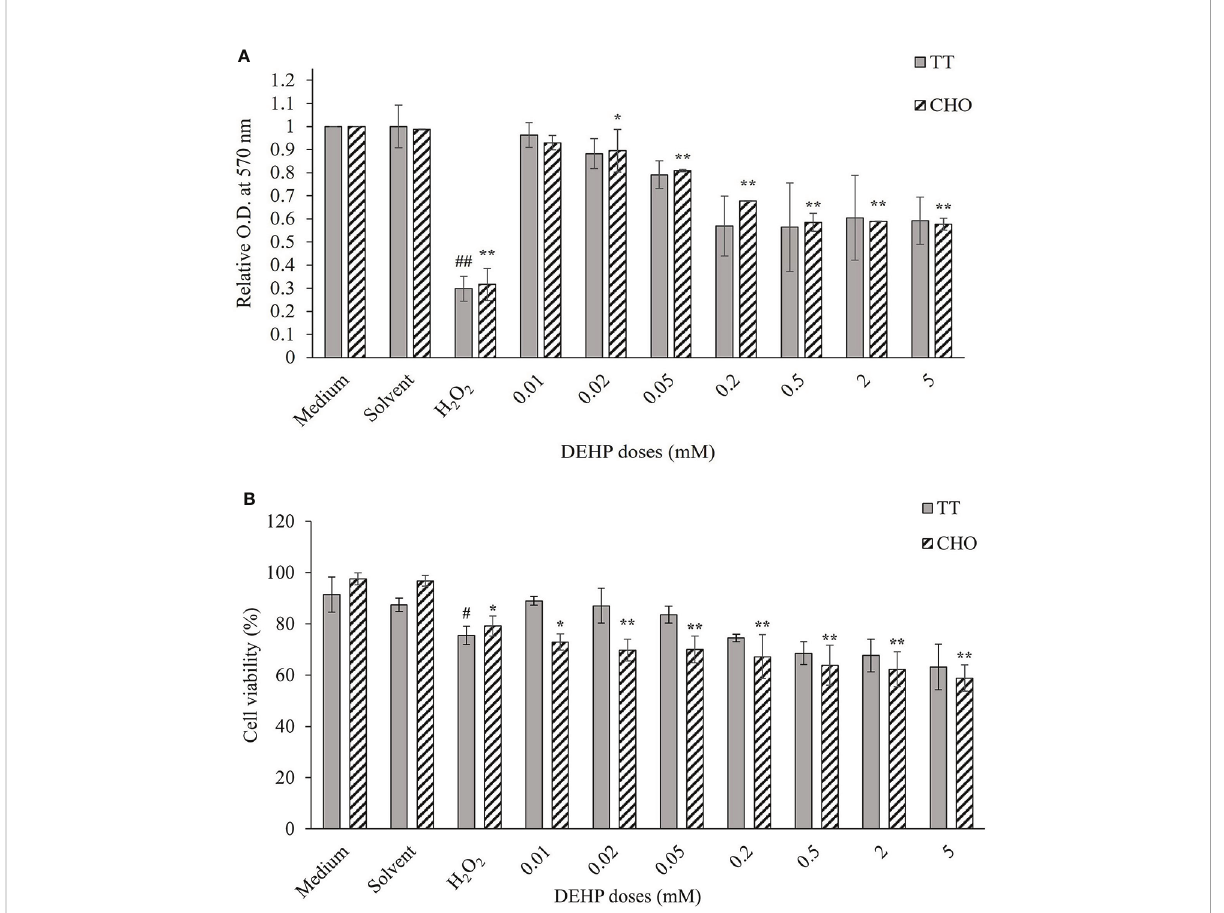
FIGURE 1 Cellular viability in DEHP-exposed TT and CHO cell lines. (A) MTT assay results are displayed as a mean of the optical density (OD) at 570 nm, at each treatment level normalized to the relative solvent (DMSO) in each cell line. Data are expressed as mean ± SD of two independent experiments. (B) Trypan Blue exclusion assay results are expressed as the percentage of viable cells out of the total cells at each treatment level. Data are expressed as mean ± SD of two independent experiments. One-way ANOVA signi fi cance: # p ≤ 0.05 H 2 O 2 vs medium in TT cell line; ## p ≤